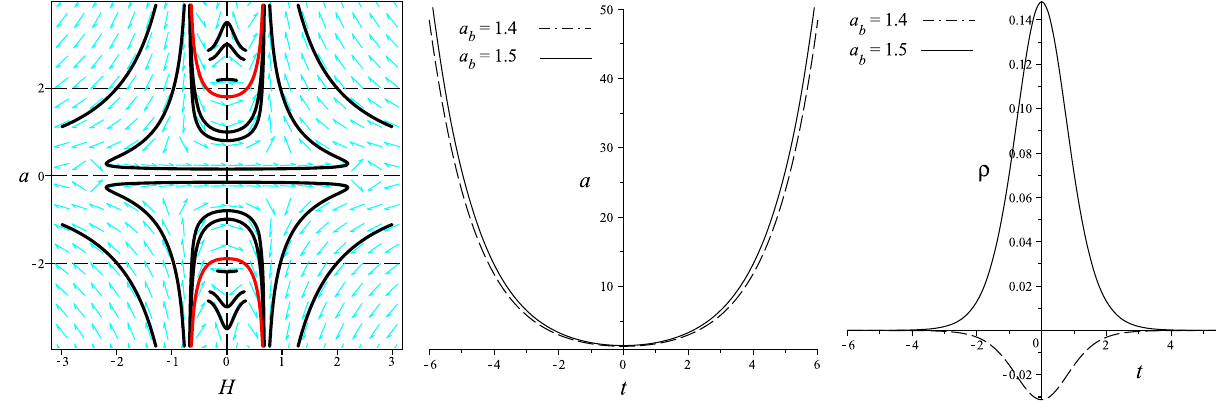
Fig. 9 Phase space of the dynamical system for the case of k = 1 ,α = − 2 ,β = 0